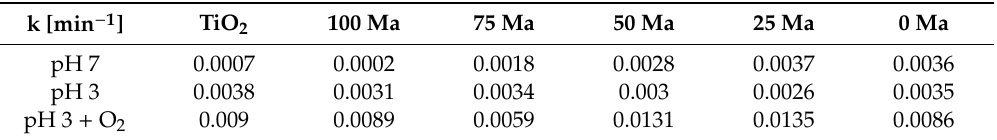
Table 2. Langmuir-Hinshelwood rate values for aniline blue degradation by the photocatalytic process with TiO 2 -foam / UV light and TiO 2 -anthocyanin-foam / visible light. k [min − 1